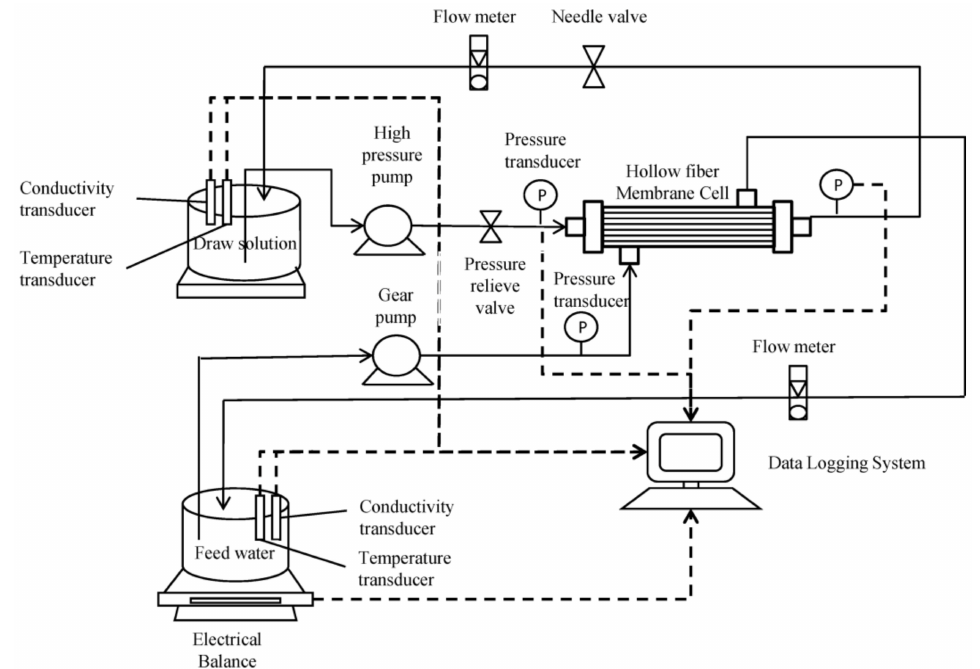
Figure 3. Schematic diagram of bench-scale PRO system